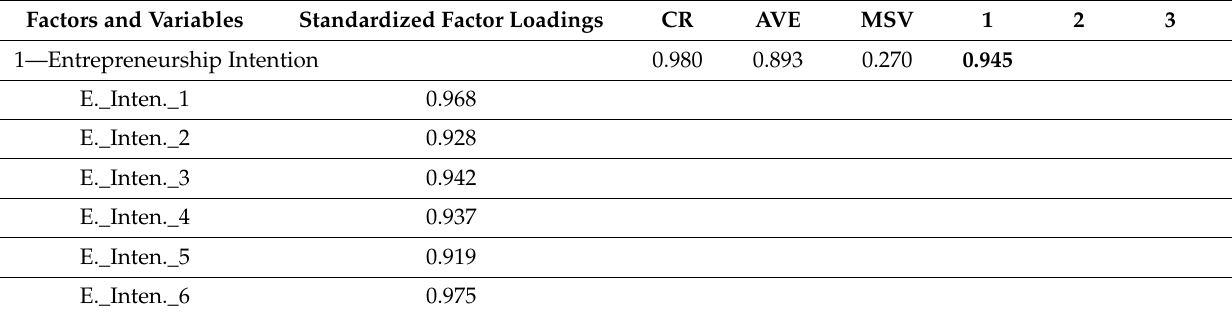
Table 2. Psychometric properties of the study